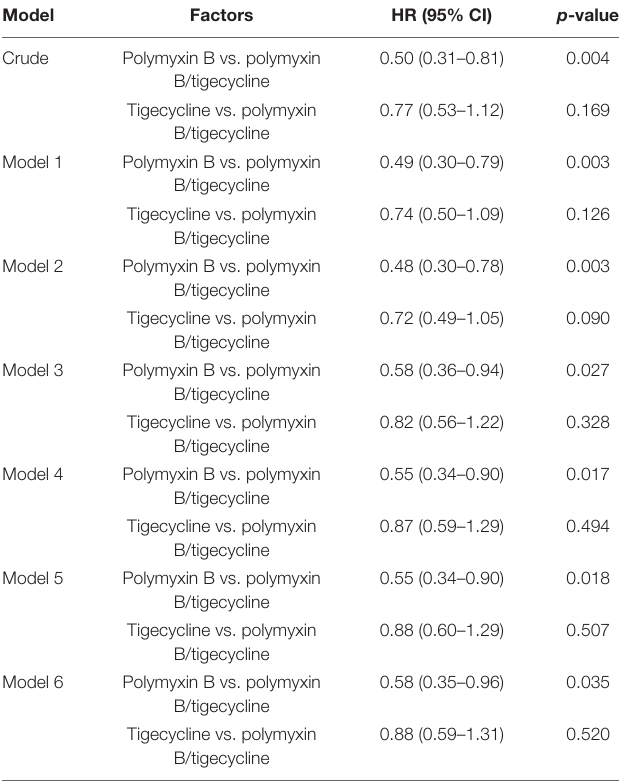
TABLE 4 | Model selection for multivariable analysis of 28-day